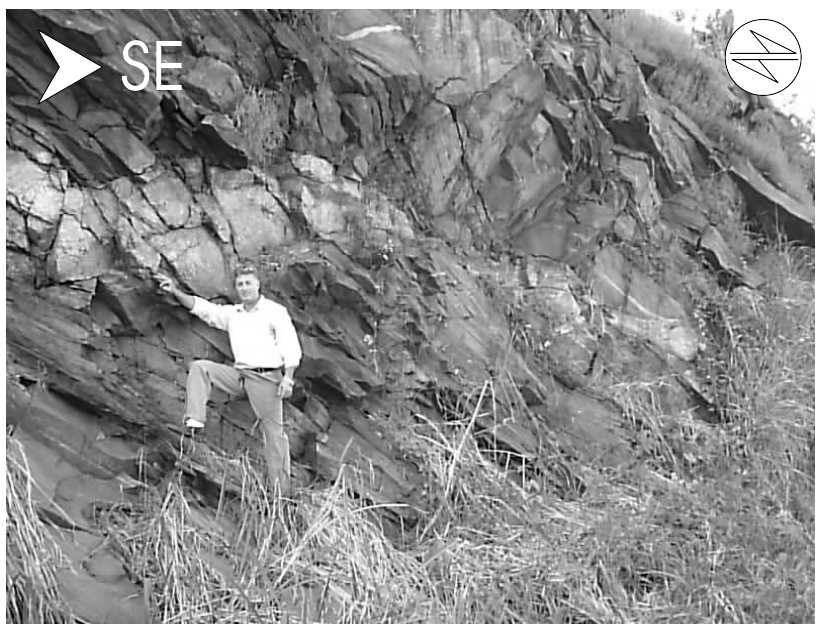
Fig. 5 – Photographs of pegmatite cross-cutting mylonitic foliation of the orthogneiss in the Serra do Azeite region, southern portion São Paulo